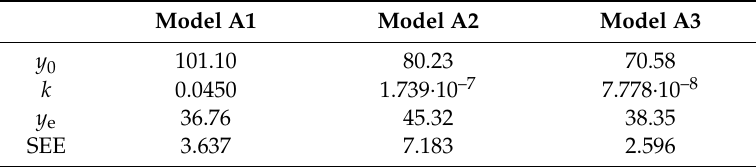
Table 3. The parameters and standard error of estimate (SEE) of the three models for the solid residue yield (% w / w) of barley straw